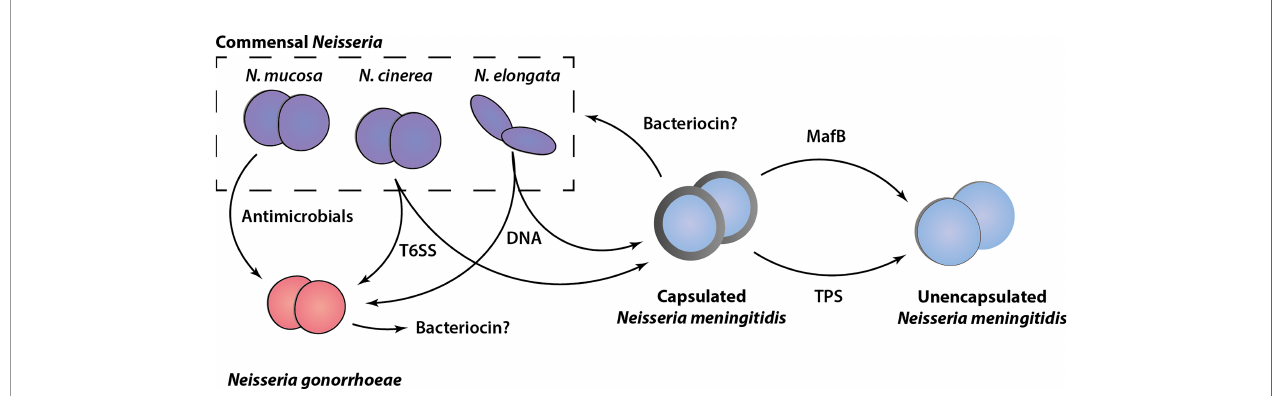
FIGURE 2 | Schematic overview of antagonism systems in Neisseria . Experimentally validated growth inhibitory activities of different Neisseria species are shown. Commensal Neisseria species ( N. mucosa , N. cinerea and N. elongata ) are shown in purple, Neisseria gonorrhoeae (red), and Neisseria meningitidis (blue) in both capsulated (with grey outline) and unencapsulated form (without grey outline) are shown. The various mediators of growth inhibition/killing are indicated, with arrows pointing from the attacker to the prey cell based on current in vitro experimental evidence. Potential bacteriocins are indicated with a question